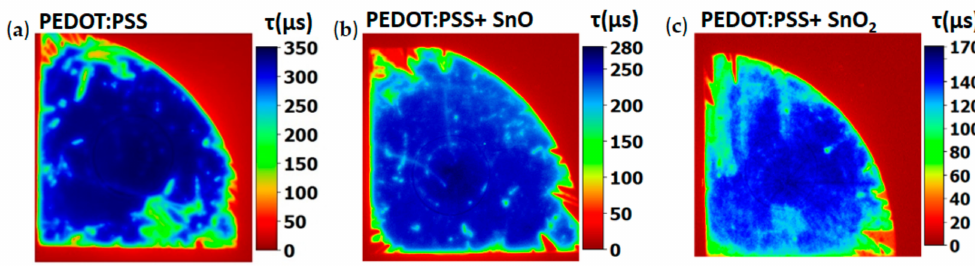
Figure 6. PL images and quasi steady state photoconductance (QSS-PC) lifetime values from: ( a ) PEDOT:PSS; ( b ) hybrid composite; ( c ) results from an analogous hybrid composite using SnO 2 nanoparticles (1% wt.), included for